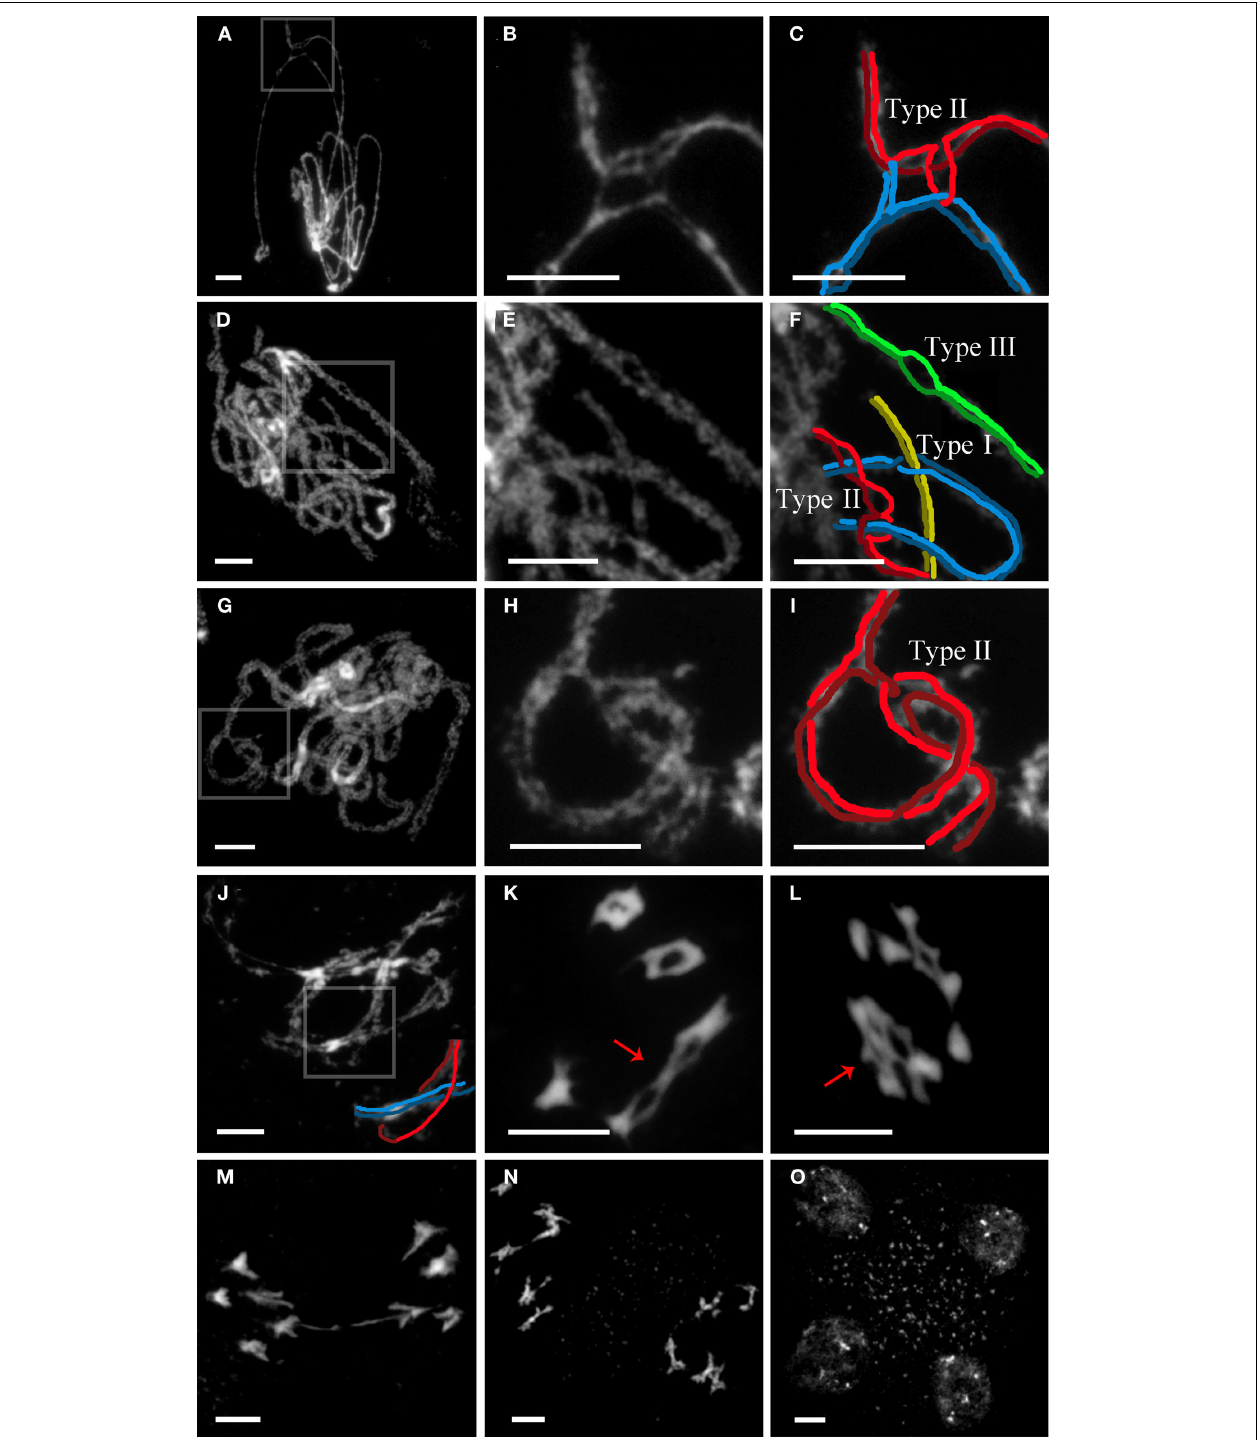
FIGURE 2 | ago9-1 displays interlocks (ILs) during late prophase I that are successfully resolved. (A,D,G) Examples of ago9-1 pachytenes. (B,E,H) Details of the ILs from (A,D,G) , respectively. (C,F,I) Possible interpretations of the ILs from (A,D,G) , respectively. (J) Diplotene with a type I IL. A schematic representation of the IL is also provided. (K) Diakinesis with two